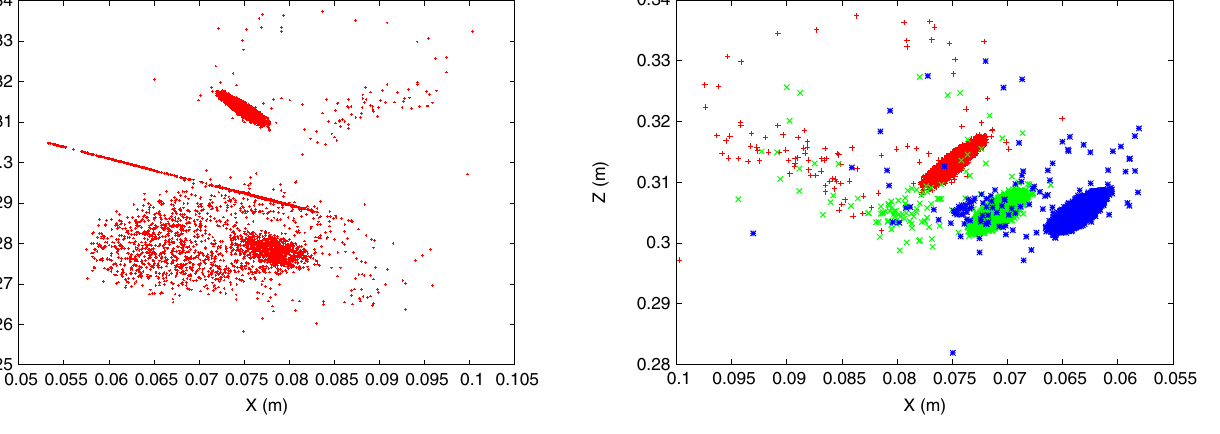
FIG. 12. X - Z view of the impact distribution of 10 000 stripped, uncaught electrons. The dense spot centered at ( x ¼ 0 : 06 , z ¼ 0 : 33 ) shows the electrons absorbed at the first inter- ception by the bottom surface. The sparsely populated ring to the right of this comes from electrons that are reflected from the bottom surface and then by the magnetic field, and finally absorbed on the bottom surface. The diagonal line centered at ( x ¼ 0 : 06 and z ¼ 0 : 3 ) shows electrons impacting the foil as- sembly. Finally, the dense spot located at ( x ¼ 0 : 065 , z ¼ 0 : 29 ), with a ringlike extension shows the electrons that were reflected from the bottom surface and absorbed at the top surface.